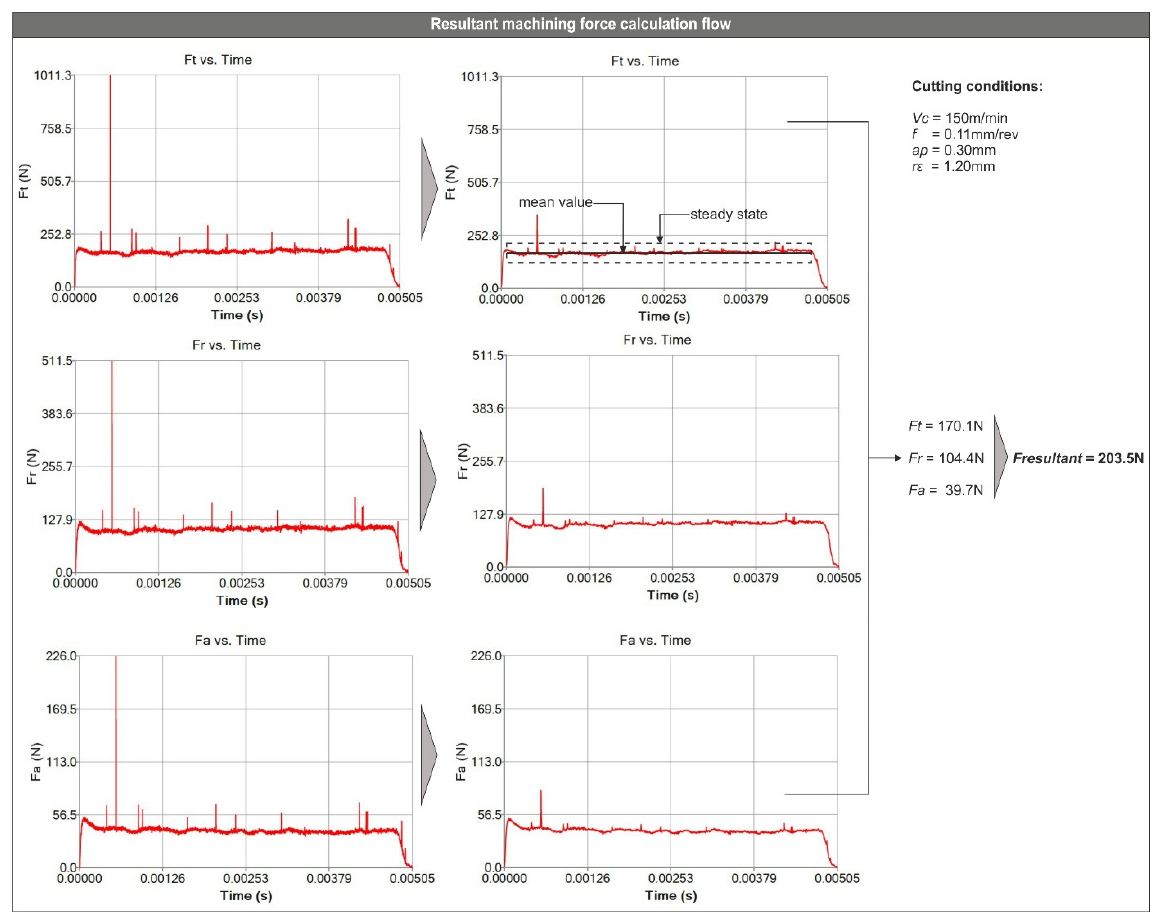
Figure 4. The steps followed for calculating F resultant .